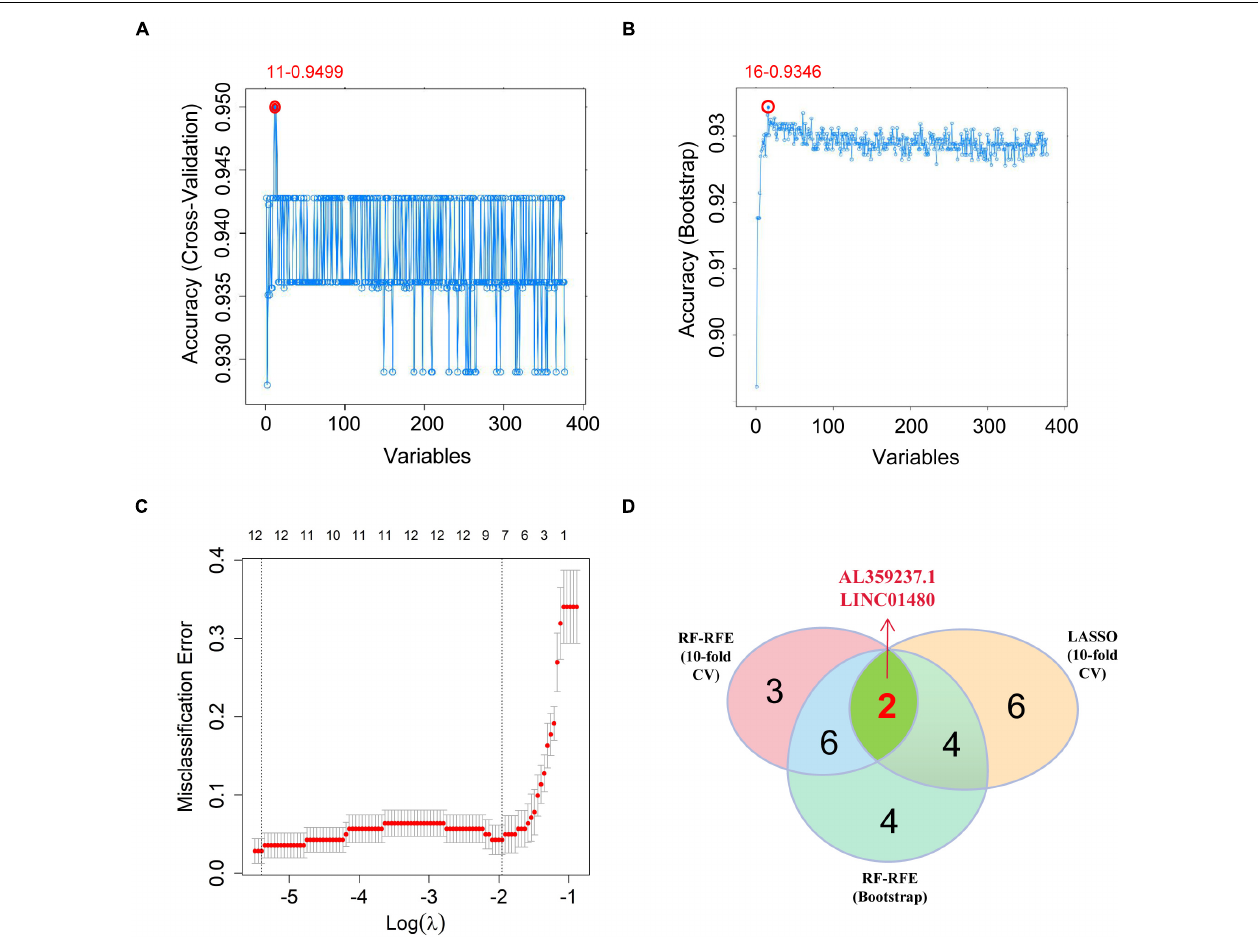
FIGURE 5 | Screening the hub immune-related lncRNAs. (A) RF-RFE algorithm to screen the immune-related lncRNAs; at the highest accuracy level, the minimum number of variables was 11. (B) The minimum number of variables was 16 based on Bootstrap. (C) 10-fold cross-validation for the penalty parameters-lambda selection in the LASSO logistic regression model; 12 variables were reserved when lambda.min was selected. (D) Venn diagram showing the intersections between the hub immune-related lncRNAs obtained by the three algorithms. LASSO, the least absolute shrinkage and selection operator; lncRNAs, long non-coding RNAs; RF-RFE, random forest-recursive feature